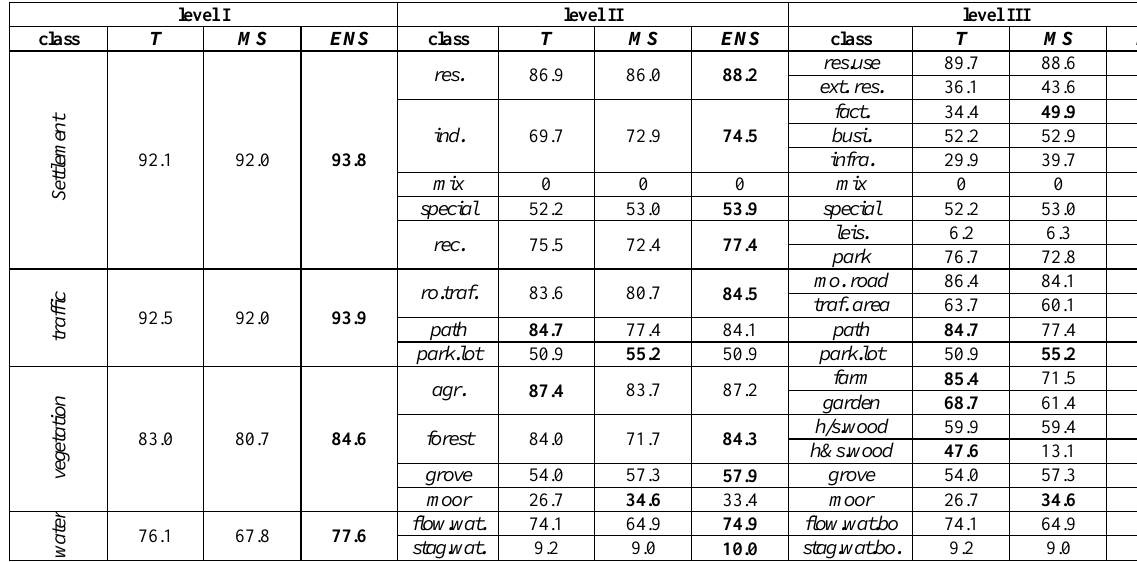
Table 3: F1 scores [%] for individual classes at all semantic levels in Hameln, achieved by the three variants LuNet-lite-JO-T (T) , LuNet-lite-JO-MS (MS) and LuNet-lite-JO-ENS (ENS) . The best values per class are printed in bold font.